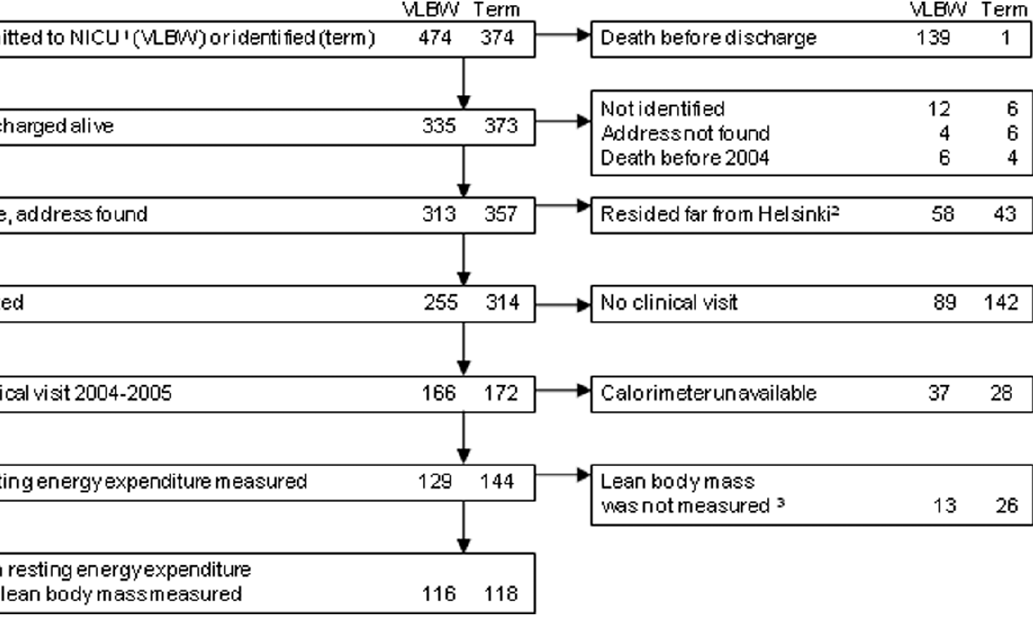
Figure 1. Flow chart showing participants selected for the present study. Participants who had both resting energy expenditure and lean body mass measured had similar characteristics compared to those invited but who did not undergo these measurements. 1 NICU denotes neonatal intensive care unit. Term subjects were indentified from the birth-hospital records for each very low birth weight (VLBW) infant. 2 Only those residing within distance of 110 km were invited. 3 Lean body mass was not measured, if the subject was pregnant, had foreign object in the body, had severe cerebral palsy or was unwilling to undergo the examination.